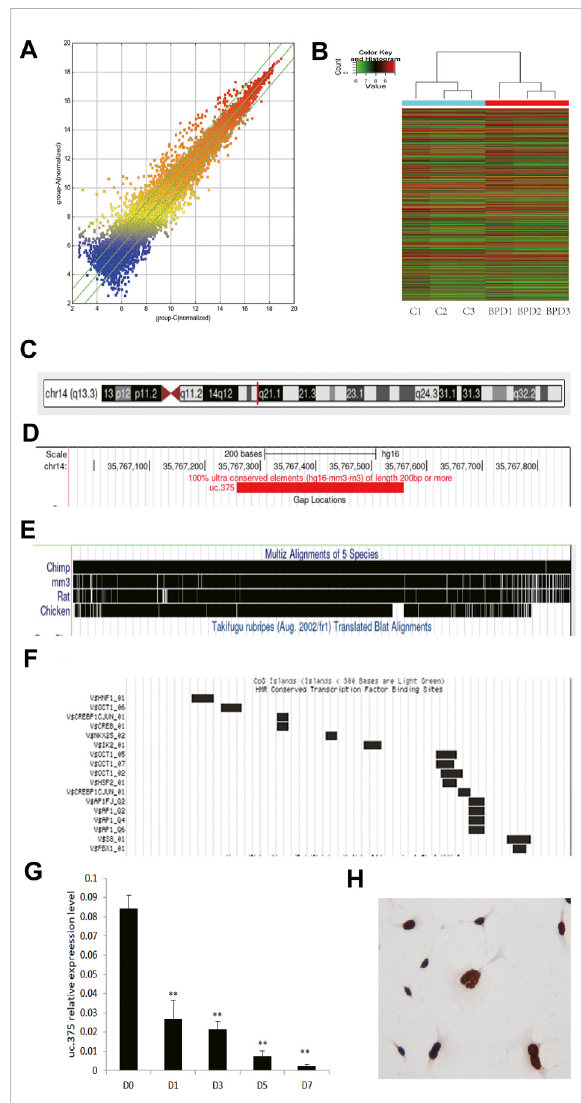
FIGURE 1 Analysis of uc.375 expression characteristics. (A) Scatter analysis chart of lncRNAs expression in hyperoxia-induced BPD lung tissue and normal lung tissue. (B) Cluster analysis.